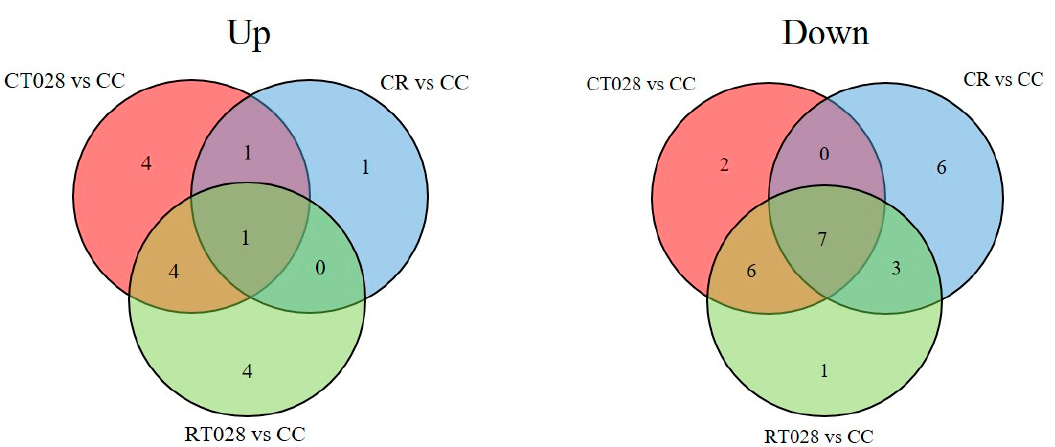
Figure 3. Venn diagram with the compounds with an Up-production and Down-production. See 17